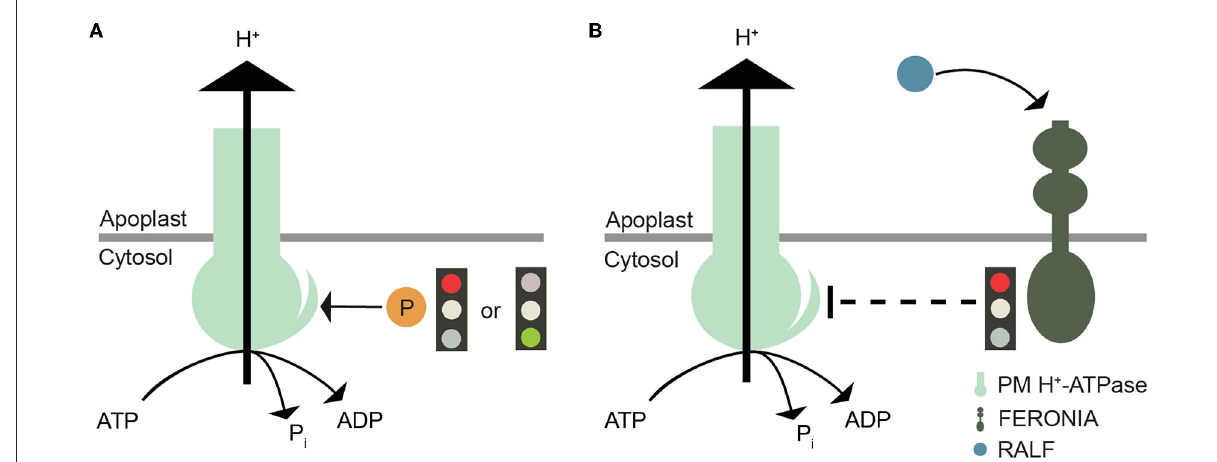
FIGURE3 Graphical illustration of plasma membrane H + -ATPase regulation. (A) Phosphorylation of specific Thr, Ser, and Tyr residues in the C-terminal autoinhibitory domain plasma membrane H + -ATPases that either promote or inhibit proton efflux by this pump. (B) Another layer of regulation of plasma membrane H + -ATPases involves their inactivation by FERONIA after RALF